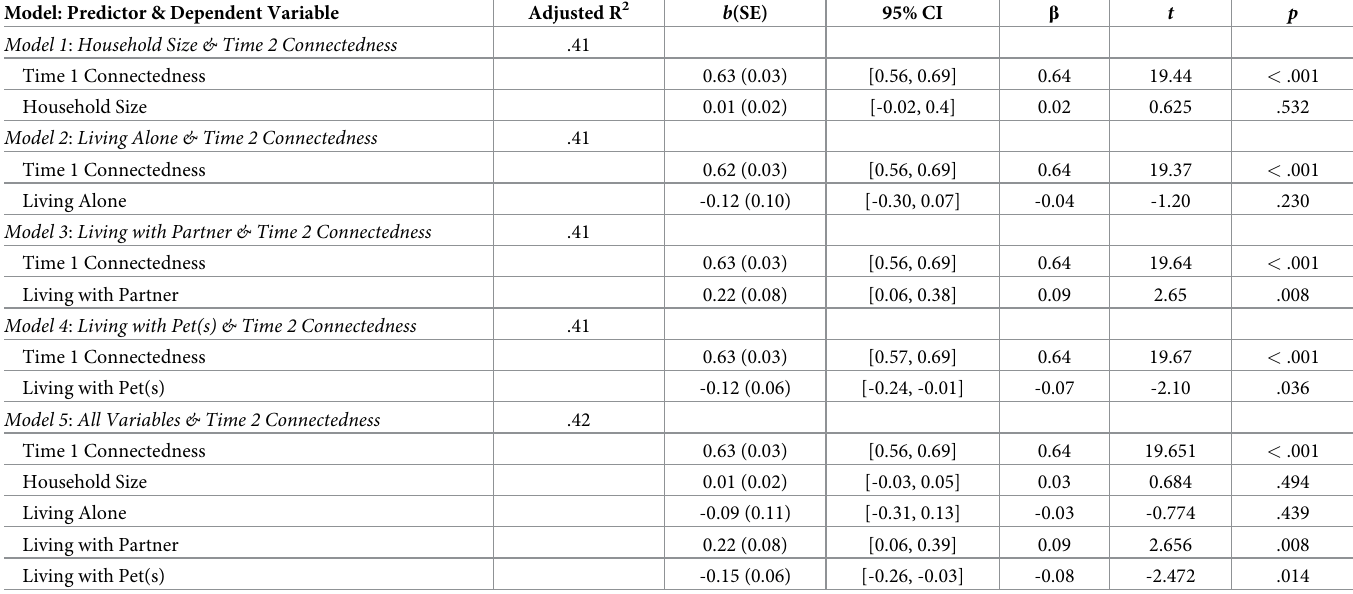
Table 3. Results of multiple regression models (Study 1). Model: Predictor & Dependent